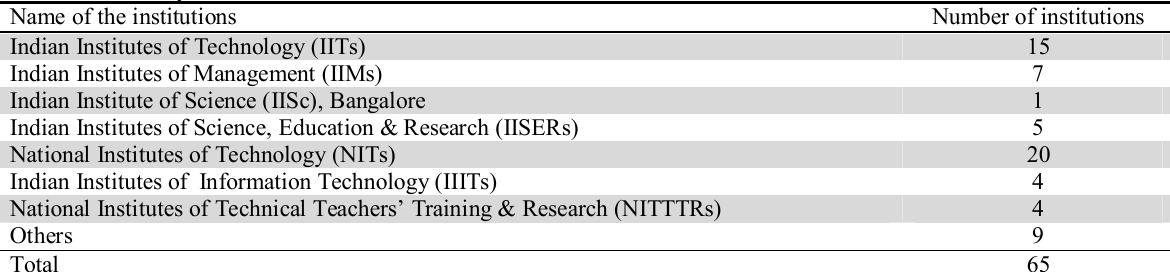
List of centrally funded